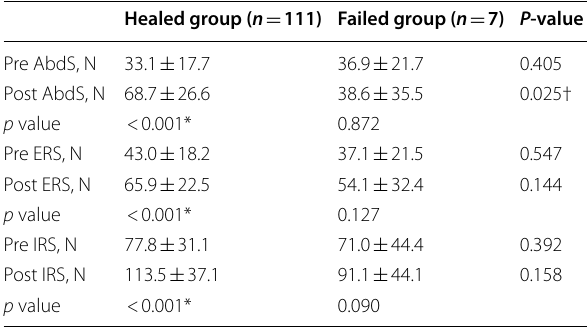
Abds abduction strength, ERS external rotation strength, IRS internal rotation strength * Statistically significant between the pre- and post-operative values ( p < 0.05) † Statistically significant between the healed and failed groups ( p < 0.05)